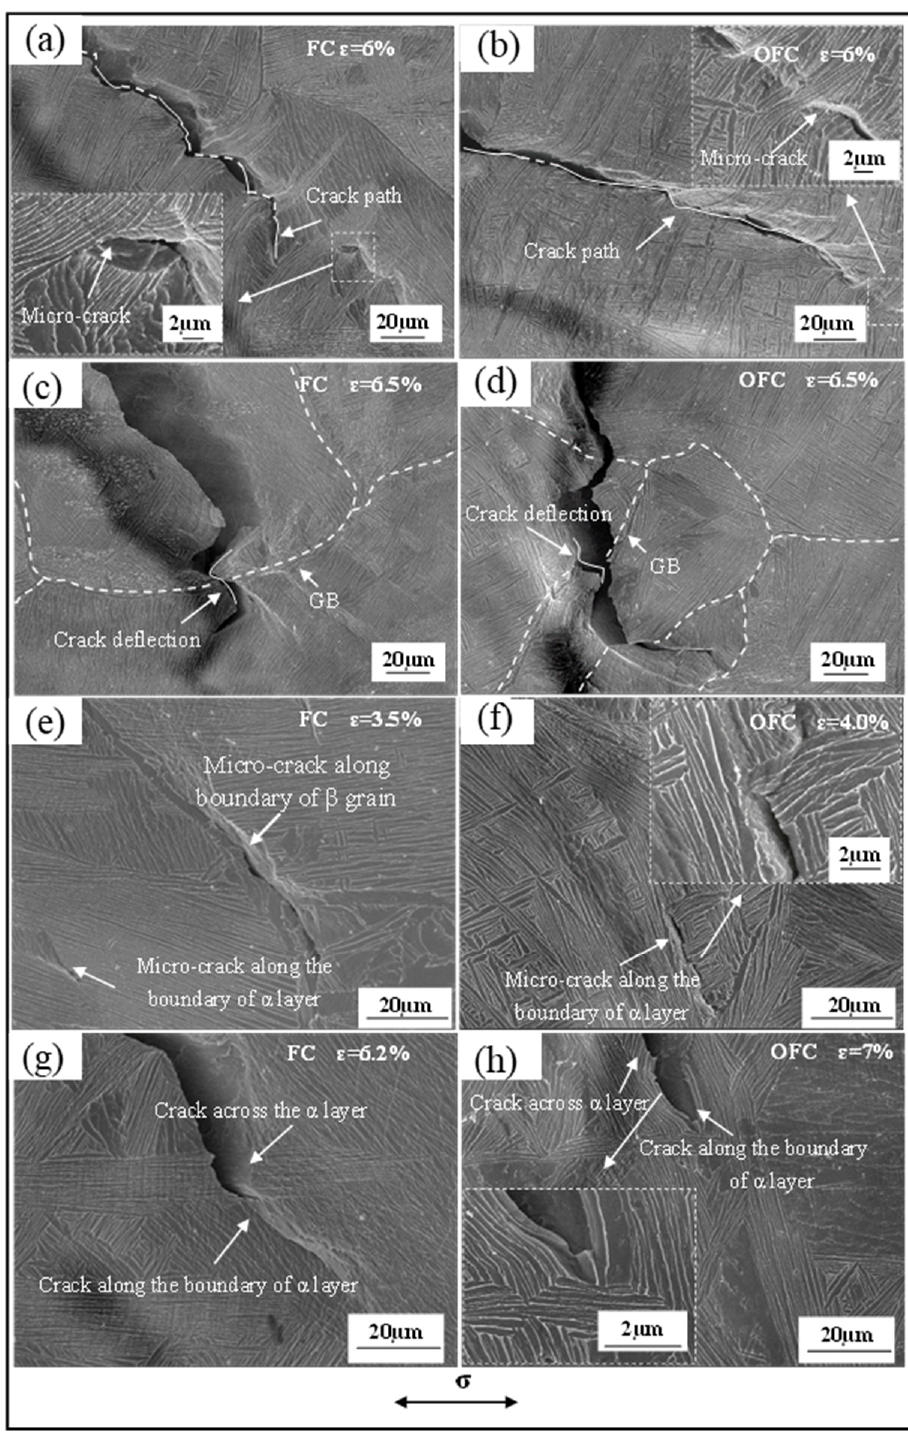
Figure 8. SEM images of crack propagation: ( a , c , e,g ) FC and ( b , d , f,h ) OFC.